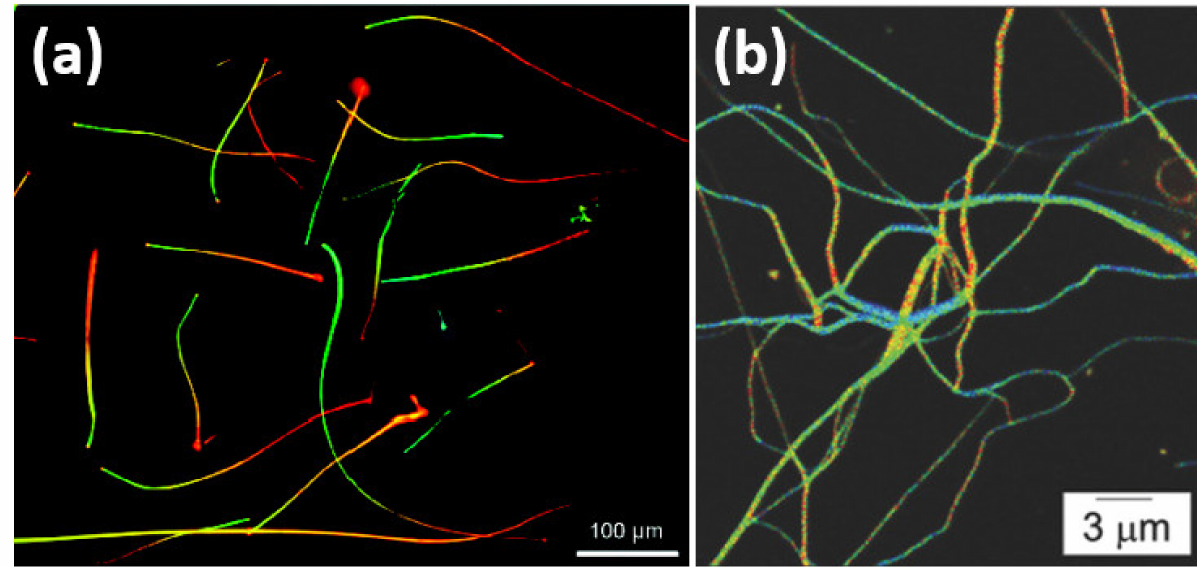
Figure 2. ( a ) CdSSe nanowires dispersed on a low-index MgF 2 substrate [12]. ( b ) CdSe-CdS quantum rods [13]. Figure reproduced with permission from ACS Publications and Wiley Online